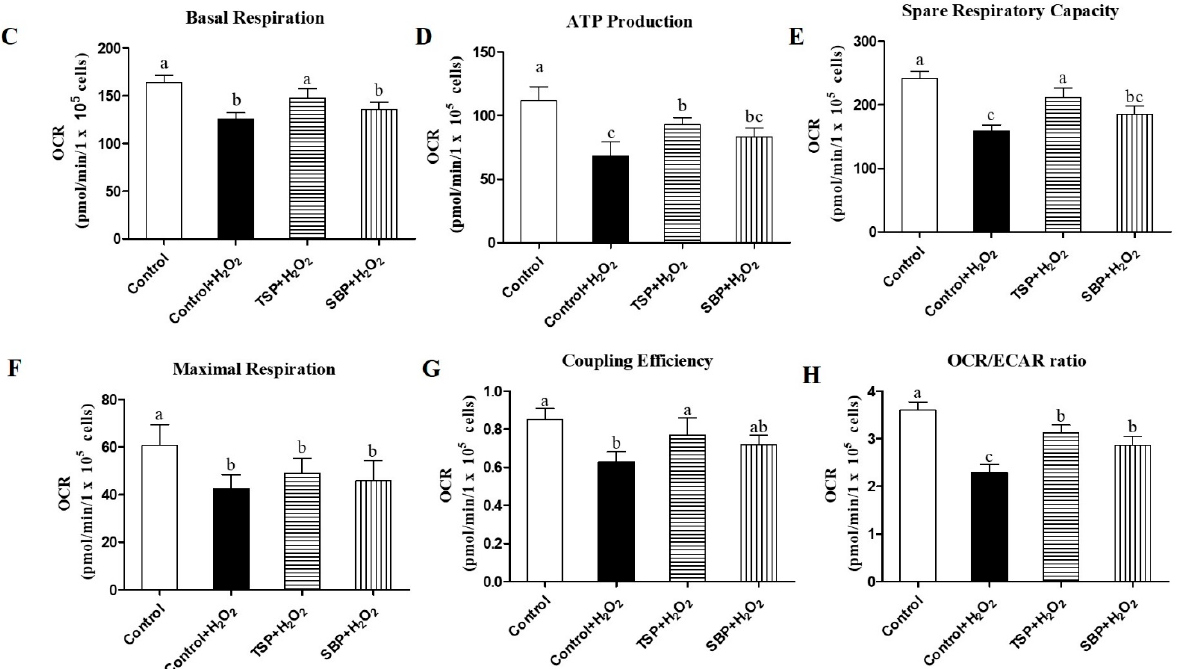
Figure 3. Improvements of SBP and TSP to H 2 O 2 -induced PC-12 cells’ mitochondrial dysfunction. 100 μ g/mL of SBP and TSP was used to treat cells for 48 h and followed with exposure of 250 μ M H 2 O 2 for 40 min. Seahorse XFe24 Analyzer was the instrument to test OCR. ( A , B ) Mitochondrial respiration profile in cells with different treatments. ( C ) Basic respiration. ( D ) Production of ATP. ( E ) The capacity of spare respiratory. ( F ) Maximum respiration. ( G ) Coupling efficiency. ( H ) The ratio of OCR/ECAR. Data are expressed as the means ± SD ( n = 3), results marked with different letters (a, b and c) are significantly different ( p < 0.05).